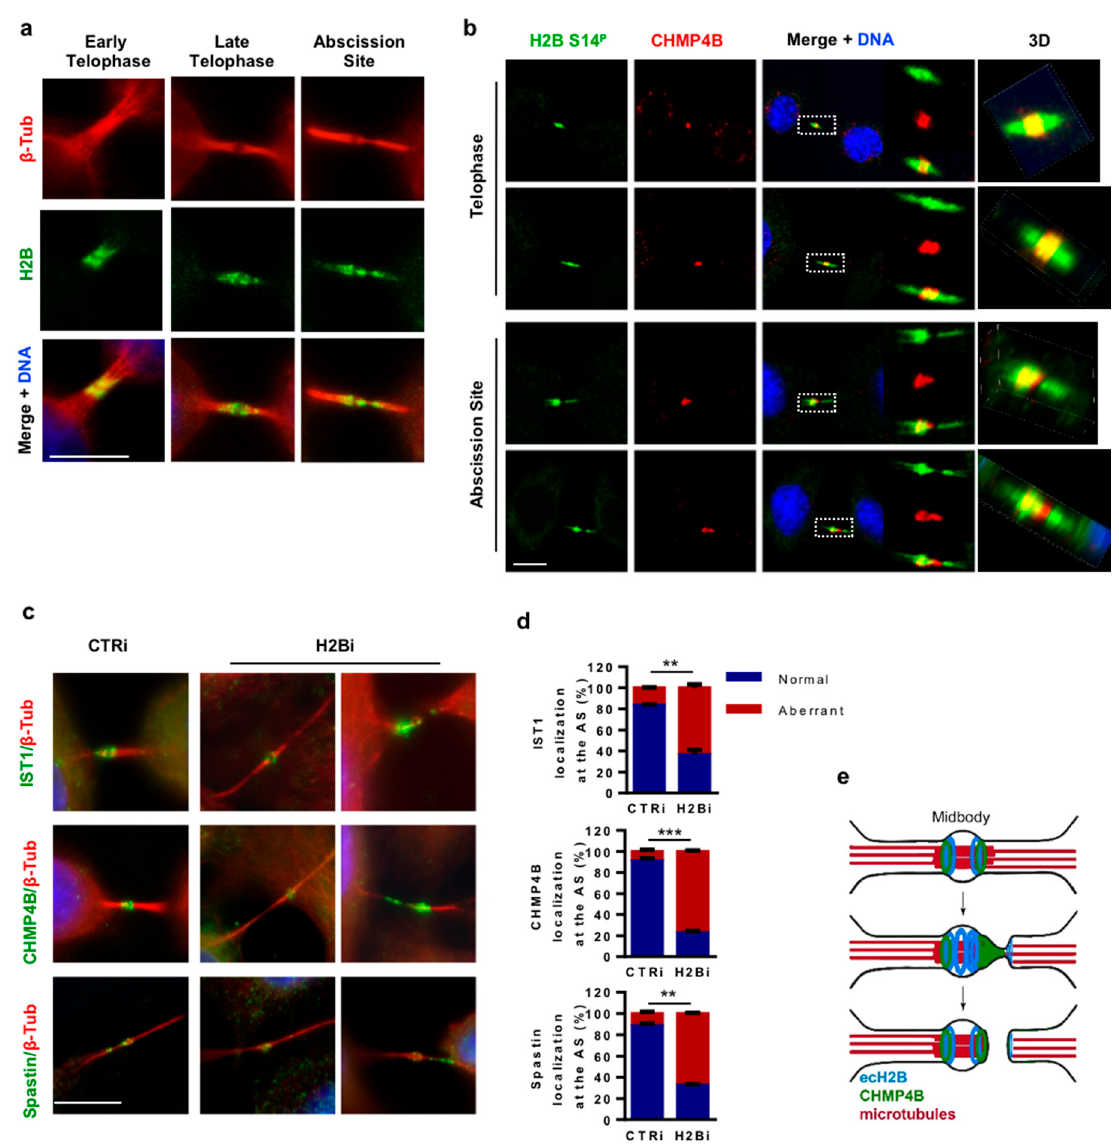
Figure 6. ecH2B contributes to abscission site. ( a ) Proliferating, asynchronous HeLa cells were fixed and analyzed by double IF with anti- β -Tubulin Ab (red) and anti-phospho-H2B-Ser14 Ab (green) in more than five independent experiments. Representative images of early and late cytokinesis and abscission sites are shown. Fifty ICBs per sample were analyzed. Scale bar is 10 µ m. ( b ) Proliferating, asynchronous HeLa cells were fixed and analyzed by double IF with anti-phospho-H2B-Ser14 Ab (green) and anti-CHMP4B Ab. Two representative images for late cytokinesis, abscission site and the relative 3D reconstructions are shown. ( c , d ) CTRi and H2Bi HeLa cells were obtained as above and analyzed by double IF for β -Tubulin (red) and the indicated proteins (green); DNA was marked with Hoechst (Blue). Representative images ( c ) and quantification ( d ) from three independent experiments of abscission site formation based on the three abscission factors are reported. Data are reported as mean ± SD. ** p < 0.01; *** p < 0.001. ( e ) Graphical abstract is reported. Microtubules are indicated in red, ecH2B is represented in blue and CHMP4B in green.